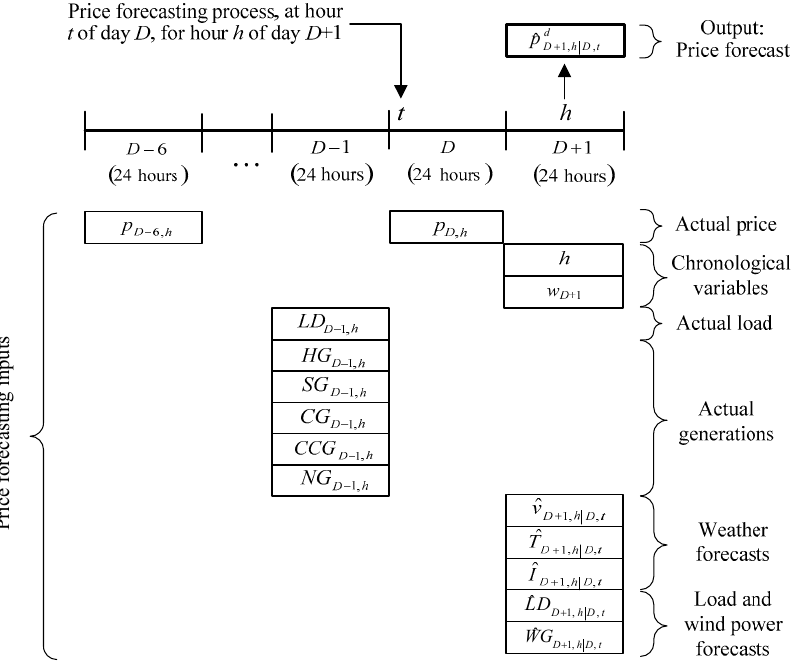
Figure 1. Time framework of daily session models for price forecasts (DSMPF models).